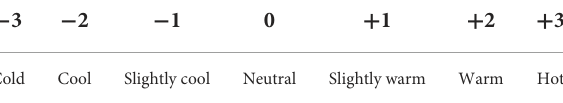
TABLE 1 The thermal comfort index PMV and its relationship to thermal sensitivity (96).